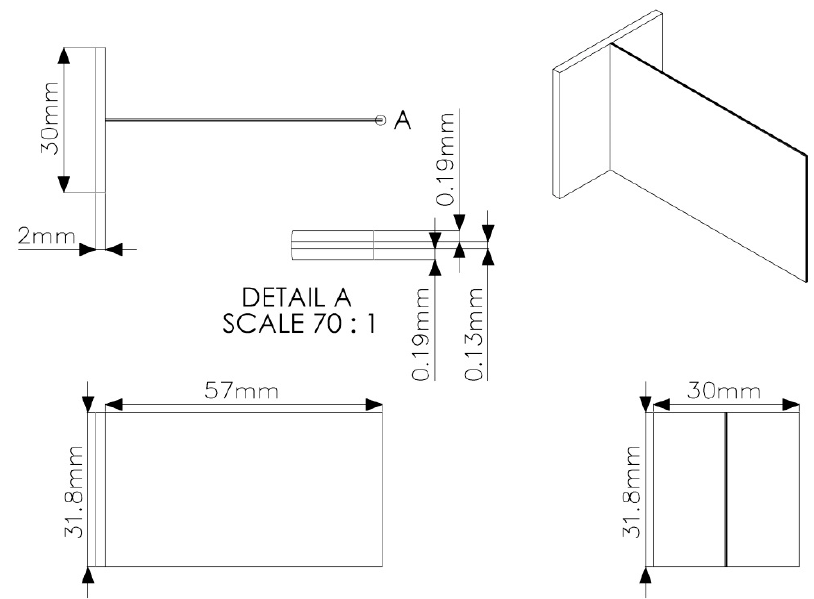
Figure 3. Structural model design of coupled bluff splitter body and elastic PVEH plate. Table 1. Material properties of structural model.